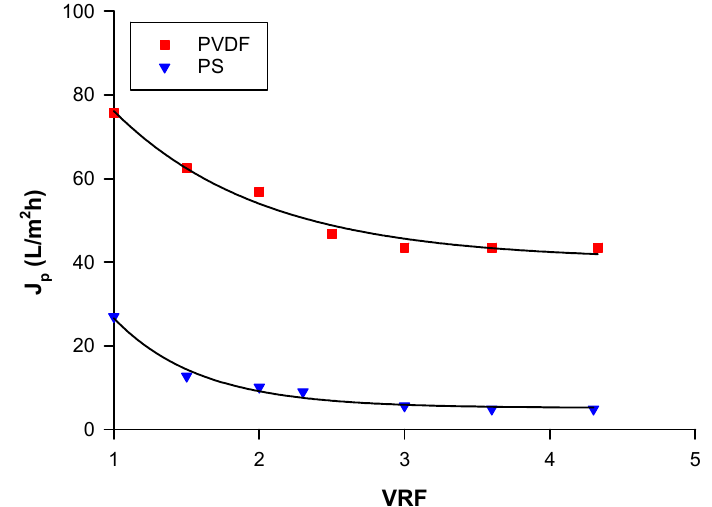
Figure 1. Ultrafiltration of Goji berry aqueous extracts with polyvinylidene fluoride (PVDF) and polysulphone (PS) membranes. Permeate flux as a function of volume reduction factor (VRF). Operating conditions: transmembrane pressure (TMP), 0.8 bar; feed flowrate (Q f ), 280 L/h; temperature (T), 21 ± 1 °C.